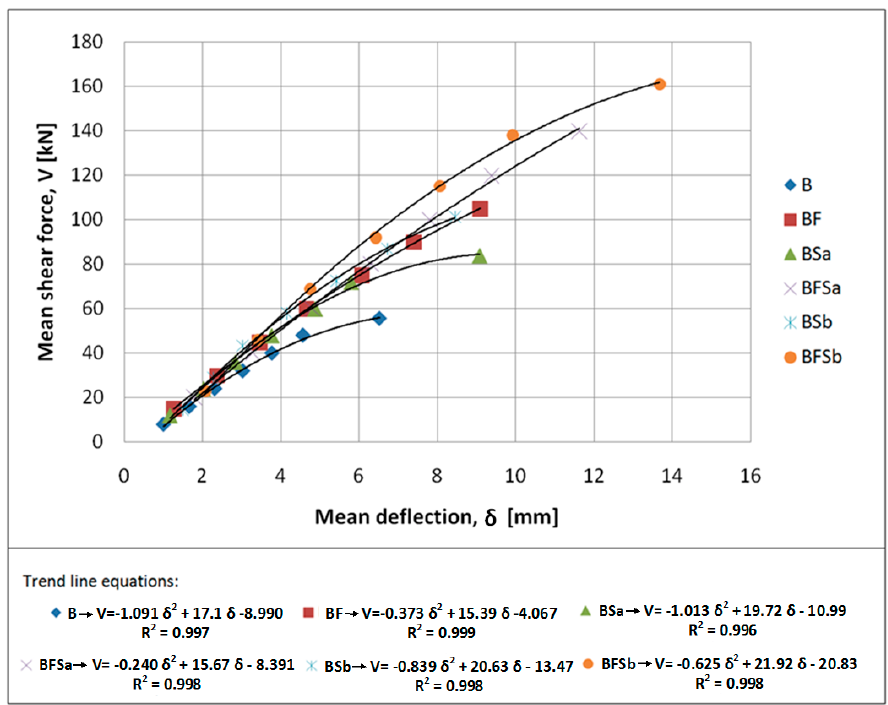
Figure 16. Relation between mean shear force and mean deflection for tested beams.